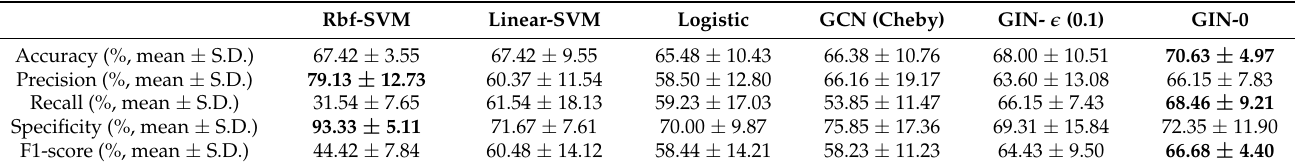
Table 2. Classification performance of five